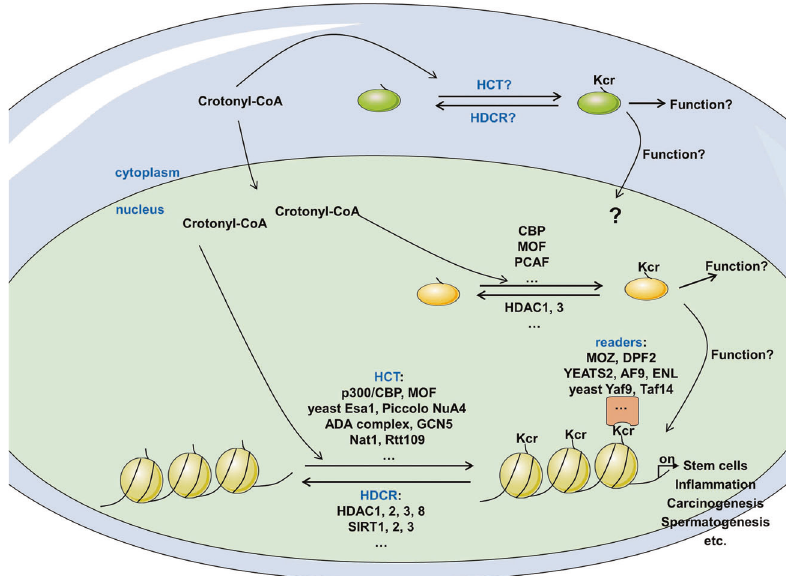
Fig. 3 The modulation of protein crotonylation. Crotonylation has been identi fi ed on lysine residues in histone and non-histone proteins. Protein crotonylation was catalyzed by HCT such as p300/CBP [15, 24], MOF [24], and crotonyltransferases including CBP, MOF, and PCAF [9]. Modi fi ed crotonyl moiety could be removed by HDCRs HDAC1, 2, 3, 8 [16], SIRT1-3 [34] and decrotonylases HDAC1, 3 [9]. Furthermore, crotonylation acts as docking marks to recruit readers, e.g., DPF family proteins MOZ, DPF2 [38], YEATS domain proteins AF9, ENL [37] and YEATS2